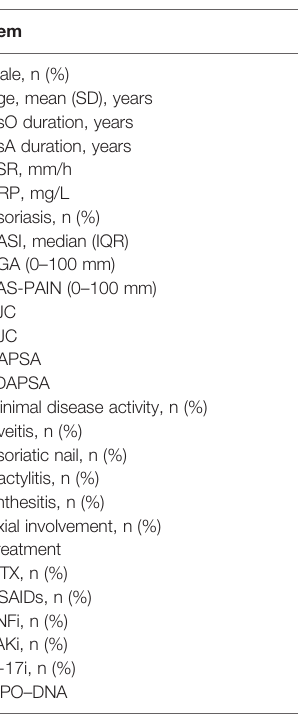
TABLE 1 | Baseline characteristics of patients with PsA and